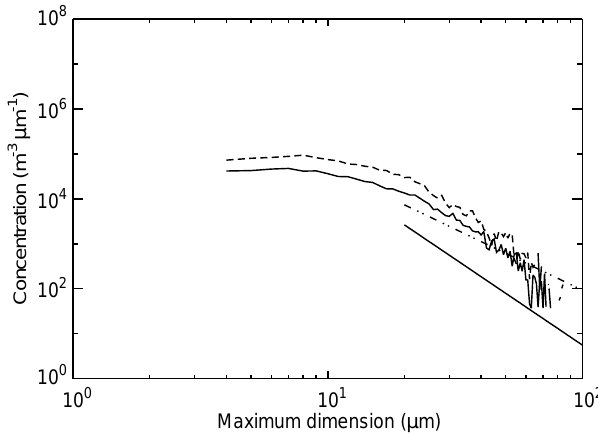
Fig. 4. Comparison of size distribution for natural cirrus (15 October 1992, solid ) and aged contrails (9 October 1992, dashed ). Lines as in